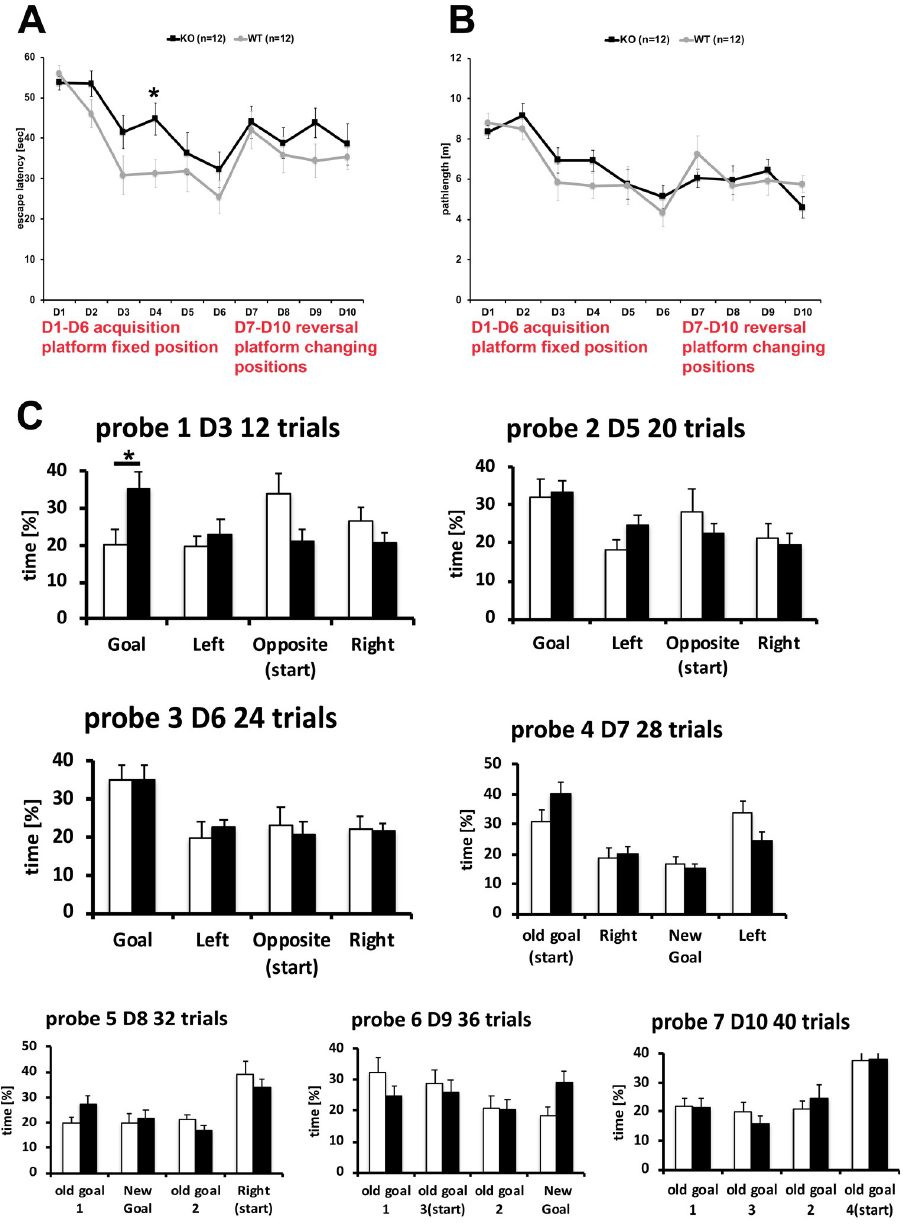
Fig 3. Flexibility in spatial learning of BT-IgSF-deficient mice in the water maze. To investigate, whether longer training improved spatial learning in BT-IgSF-deficient mice, the water maze protocol 3 was conducted. During this long acquisition phase and reversals, the escape latencies (A) and pathlengths (B) of BT-IgSF-deficient (black line) and control littermate mice (grey line) did not differ significantly contrasting the compromised flexibility after short acquisition (Fig 2). The evaluation of the goal quadrant preferences during the interspersed probe trials (C) revealed that control littermate mice (white columns) had established a preference already after 12 trials (probe 1) whereas BT-IgSF-deficient (black columns) required 20 trials (probe 3). After changing the platform position daily, quadrant preferences of BT-IgSF-deficient and controls were similar (probe 4–7).